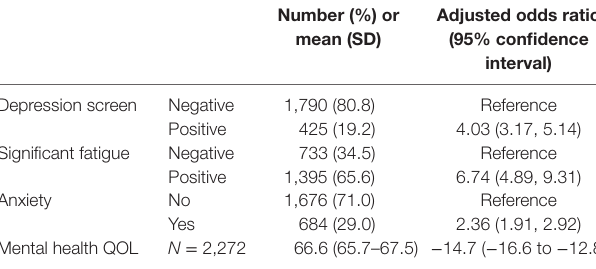
TaBle 2 | Adjusted associations of health outcomes with substantial pain. a